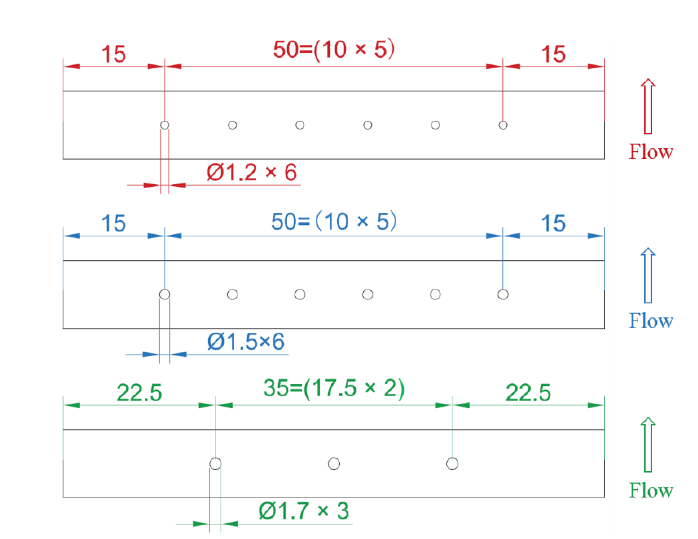
Figure 3. Model in test.